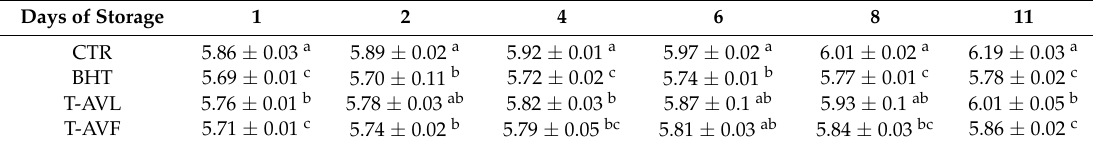
Table 3. The pH values of raw beef patties formulated with powdered leaves and flowers of A. vulneraria during storage at 4 ± 1 ◦ C CTR (Control sample without antioxidant), BHT (treatment with synthetic antioxidant (Butylated hydroxytoluene)), T-AVL (treatment with A. vulneraria leaf), T-AVF (treatment with A. vulneraria